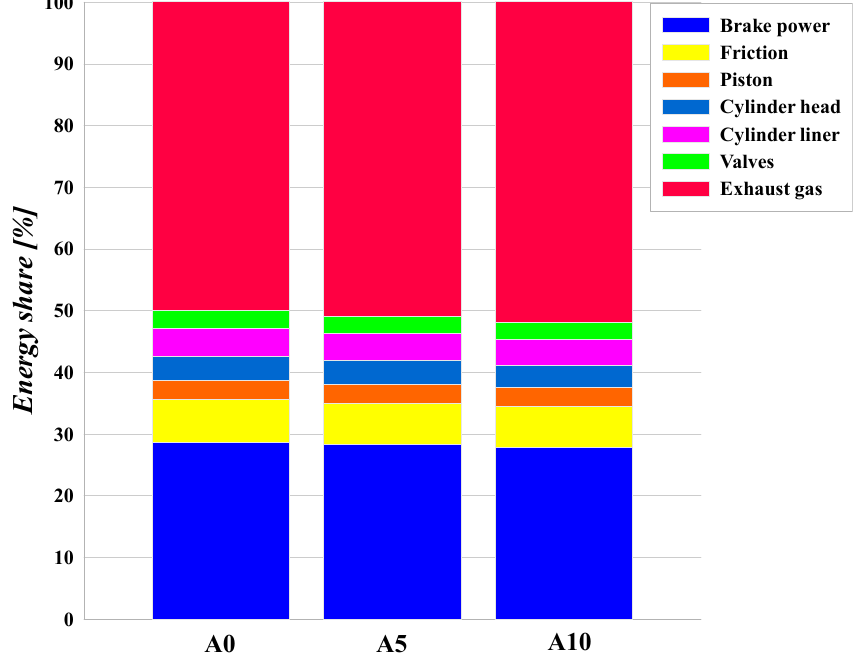
Figure 8. The energy shares of fuel energy converted to brake power and friction, and that wasted at engine rated